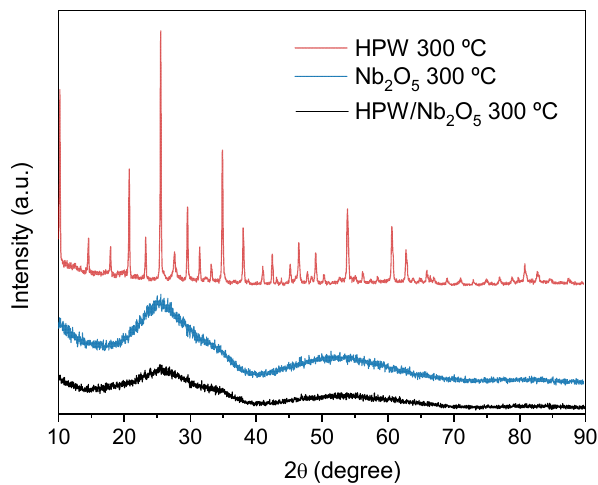
Figure 3. X-ray powder di ff raction (XRD) patterns of the HPW active phase, Nb 2 O 5 support, and HPW / Nb 2 O 5 catalyst calcined at 300 ◦ C.